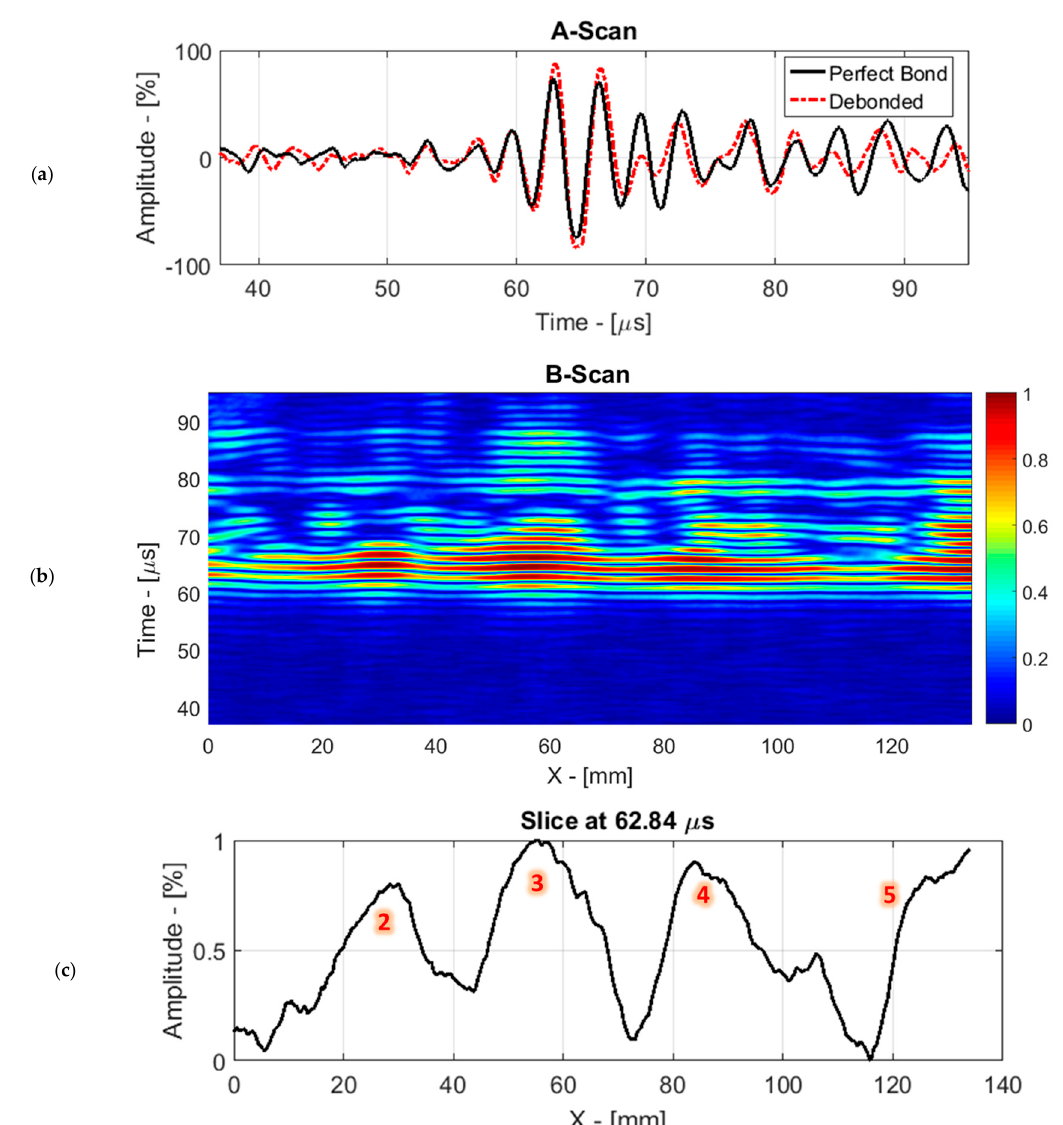
Figure 18. Air-coupled to contact guided waves results: ( a ) A-scan; ( b ) B-scan; ( c ) slice at time = 62.84 µs. Figure18. Air-coupledtocontactguidedwavesresults: ( a )A-scan; ( b )B-scan; ( c )sliceattime = 62.84 µ